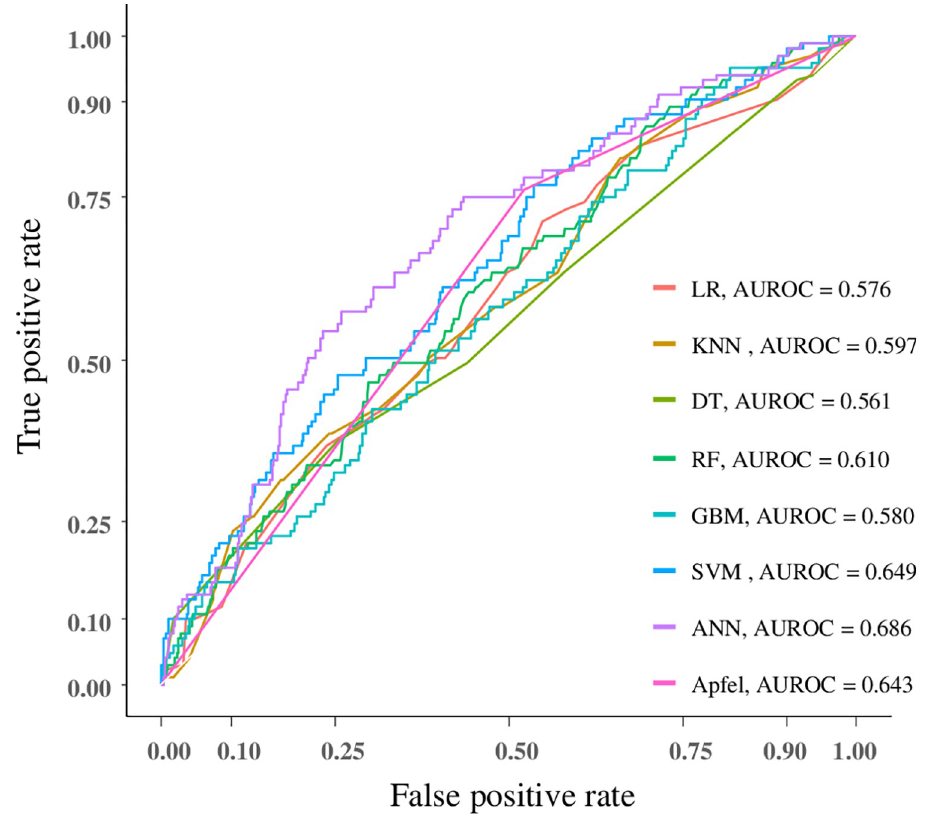
Fig 3. Areas under the receiver operating curve for the machine learning and Apfel